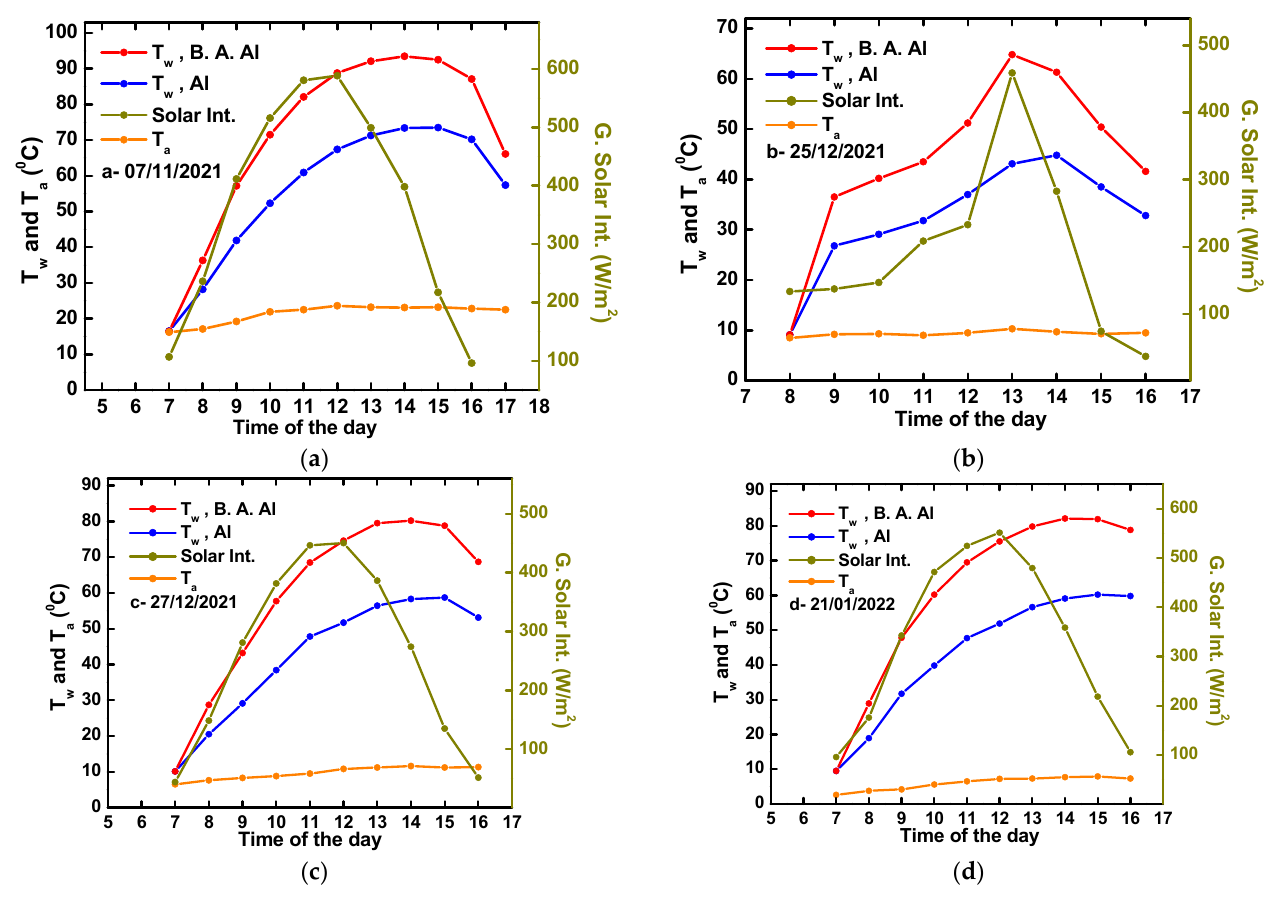
Figure 10. a, b, c, d. Water and ambient temperatures (T w and T a ) and global solar intensity as a function of the time of day, Al and B. A. Al containers, ( a ) Mostly sunny day 7 November 2021, autumn